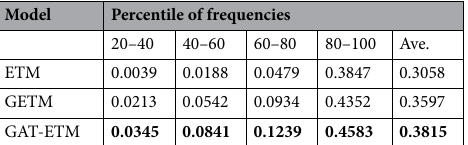
Table 5. Top-30 drug-wise imputation precision at different percentiles of drug frequencies. The best score for each metric are in [bold].